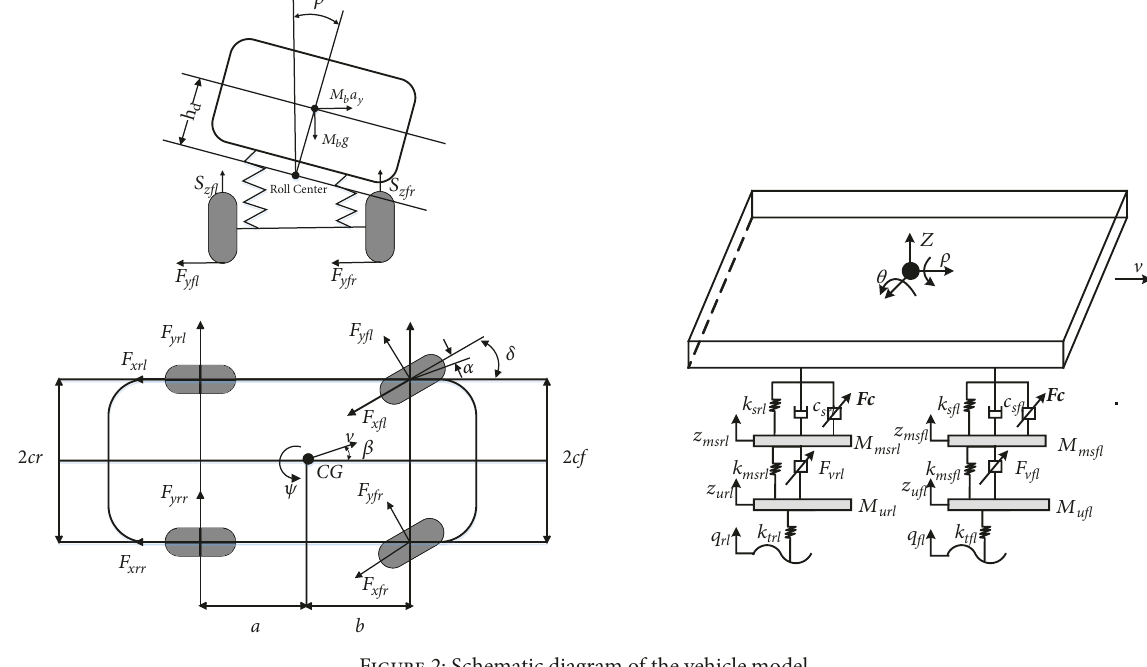
Figure 2: Schematic diagram of the vehicle